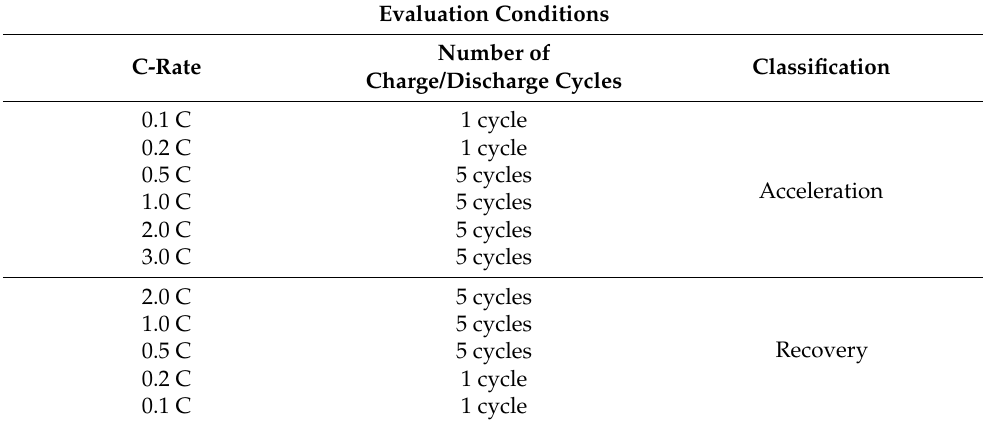
Table 2. C-rate conditions set for the evaluation of rate performance